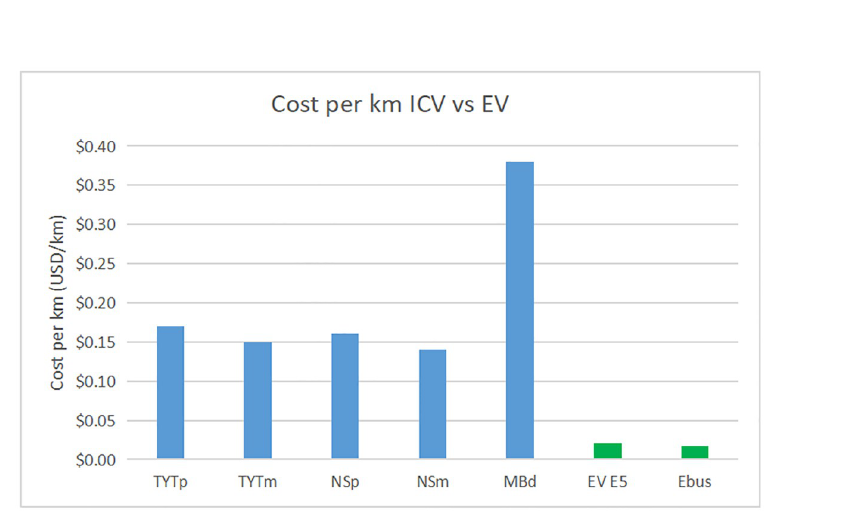
Fig 6. ICV vs EV cost per km.